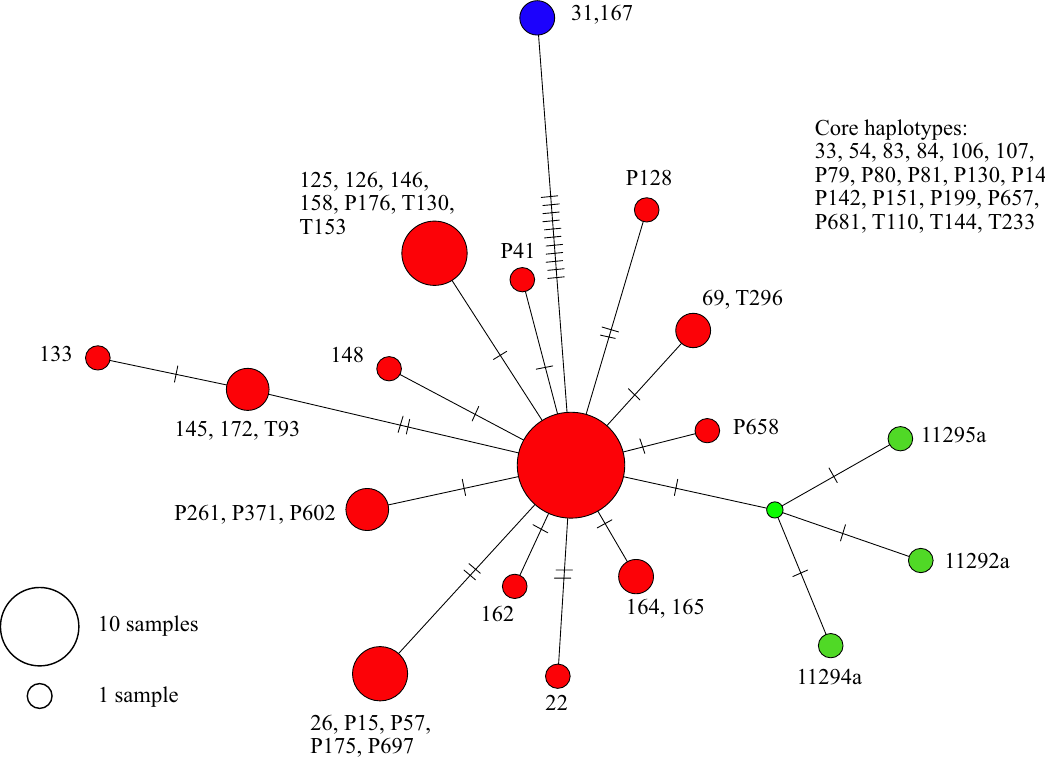
Figure 7. Panicum miliaceum haplotype network. A chloroplast genome haplotype network from the three medieval Areni-1 grains and 50 modern accessions of P. miliaceum was generated using the PopArt program (http:// popart. otago. ac. nz/ index. shtml) with the median joining network algorithm. The hash marks on the lines connecting the circles indicate the number of mutations separating the haplotypes. The accessions contained in the core haplotype, the large node at centre of network, are listed in the upper right of the figure. Modern domesticated accessions are given in red, wild modern accessions are given in blue, and the Areni-1 millet are given in